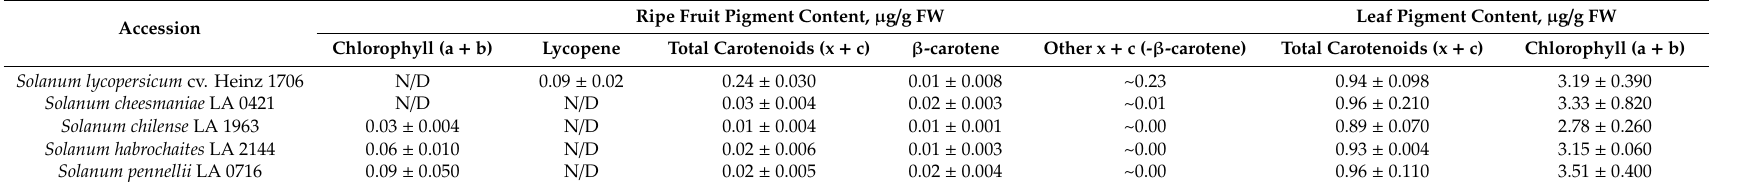
Table 2. Chlorophyll and carotenoid content in ripe fruits and leaves of analyzed tomato